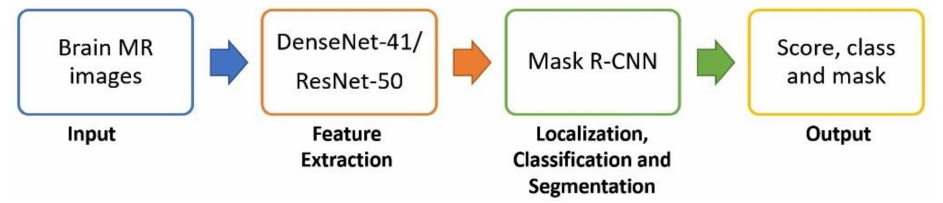
Figure 1. Block diagram of the proposed method.